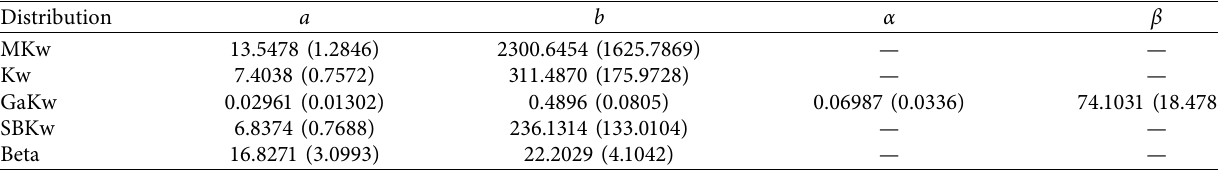
Table 10: MLEs and their standard errors (in parentheses) for data set 4.